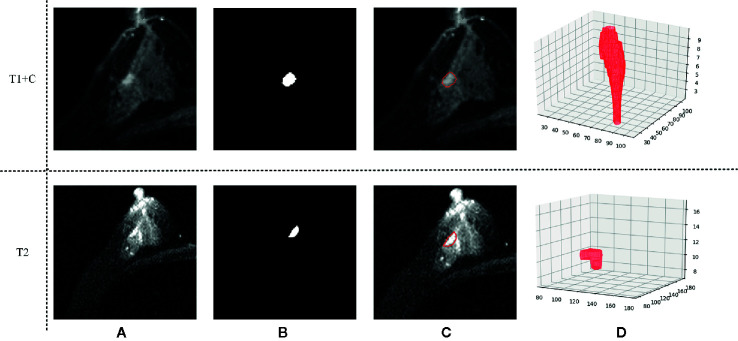
An example of the segmentation result. (A) Shows the original T1 + C/T2 image, (B) shows the masks generated by our semi-automatic segmentation method, (C) shows the final segmentation result, and (D) shows the 3D tumor volume.